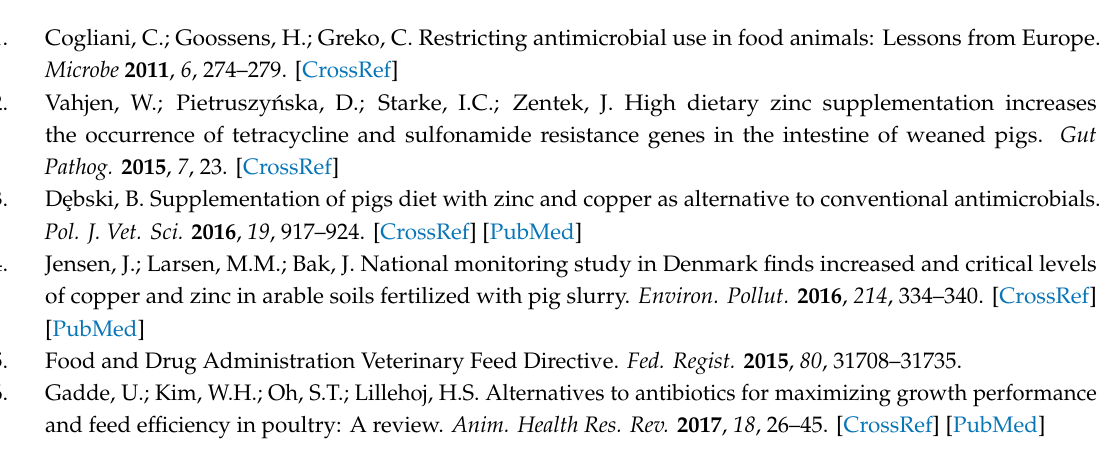
Table S1: Performance of post-weaning pigs fed diets containing a pharmacological dose of Zn and carbadox, Table S2: Ingredient and nutrient composition of experimental diets (as-fed